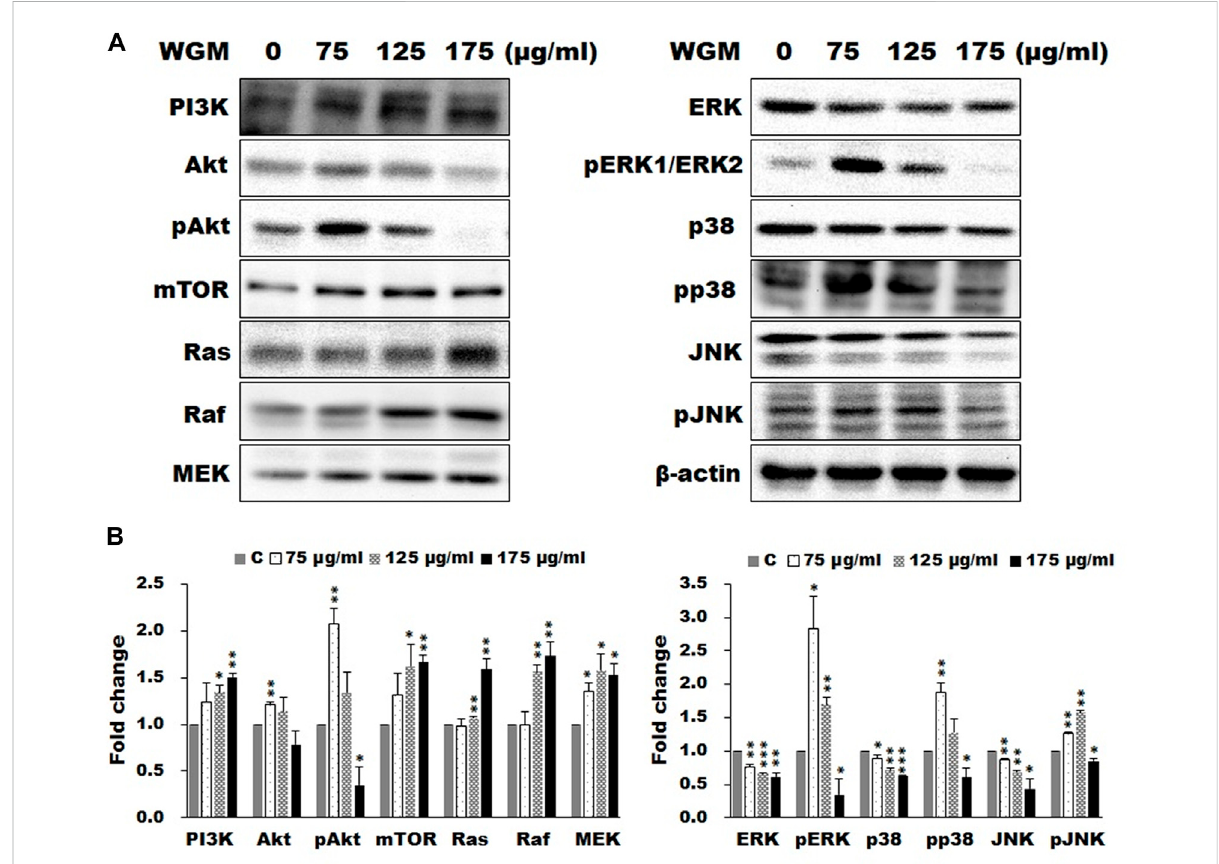
FIGURE 3 EffectsofWGMextractsontheproteinlevelsofthemembersofmTORandMAPsignalingpathwaysinHep3Bcells.TheeffectsofWGMextracts on mTOR and MAPK signaling pathway-related proteins were analyzed by Western blotting. Cells were treated with vehicle alone or with 75, 125 or 175 μ g/ml WGM extracts for 24 h. Protein samples wereanalyzed by SDS-PAGE (5% for PI3K and mTOR, 8% for Raf, 10% for Akt and Aktp (S473), 12% for β -actin, ERK, ERK1p(Thr202/Tyr204)/ERK2p(Thr185/Tyr187), JNK, JNKp(Thr183/Tyr185), MEK, p38 and p38p (Thr180/Tyr182) and 14% for Ras), and then probed with primary antibodies followed by secondary antibodies. (A) Representative blots. (B) The blots were quanti fi ed by Lane